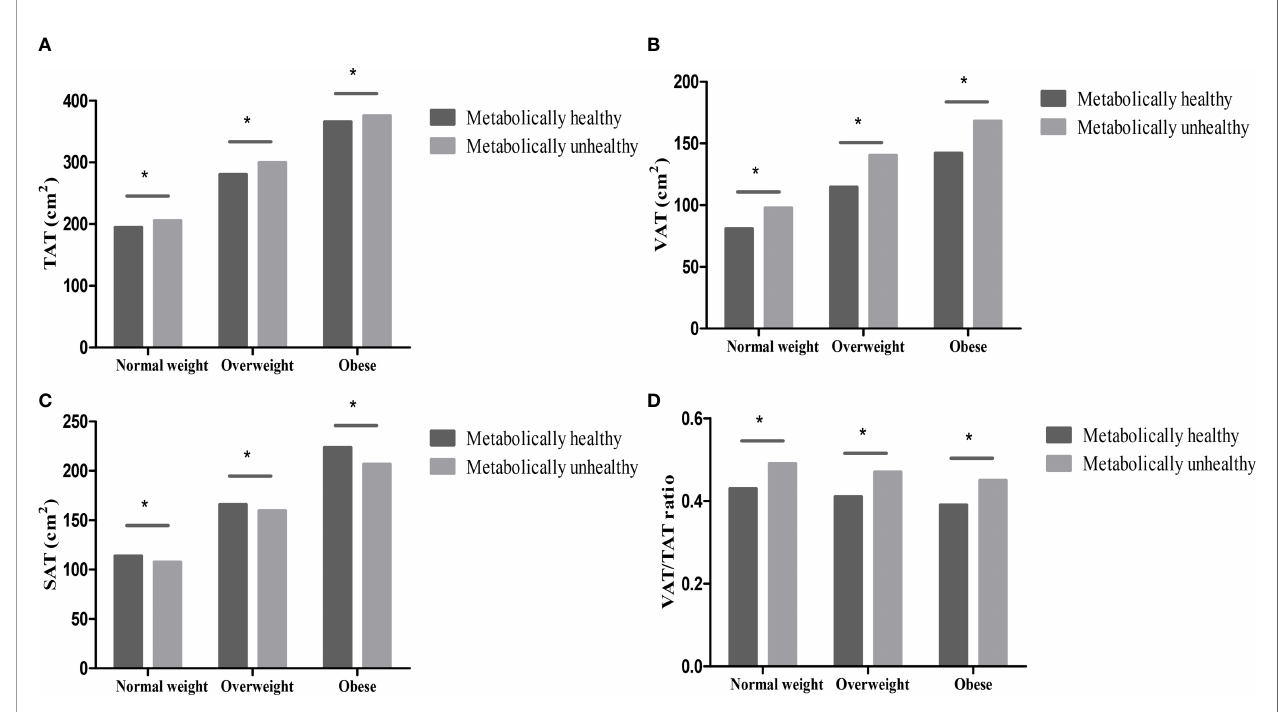
FIGURE 1 | Abdominal fat distribution in different metabolically phenotypes. (A) TAT in different metabolically phenotypes. (B) VAT in different metabolically phenotypes. (C) SAT in different metabolically phenotypes. (D) VAT/TAT ratio in different metabolically phenotypes. * p value < 0.05. TABLE 2 | Odds ratio of abdominal fat distribution and skeletal muscle category for metabolically unhealthy according to BMI category. Normal weight Overweight Obese OR, 95%CI p value OR, 95%CI p value OR, 95%CI p